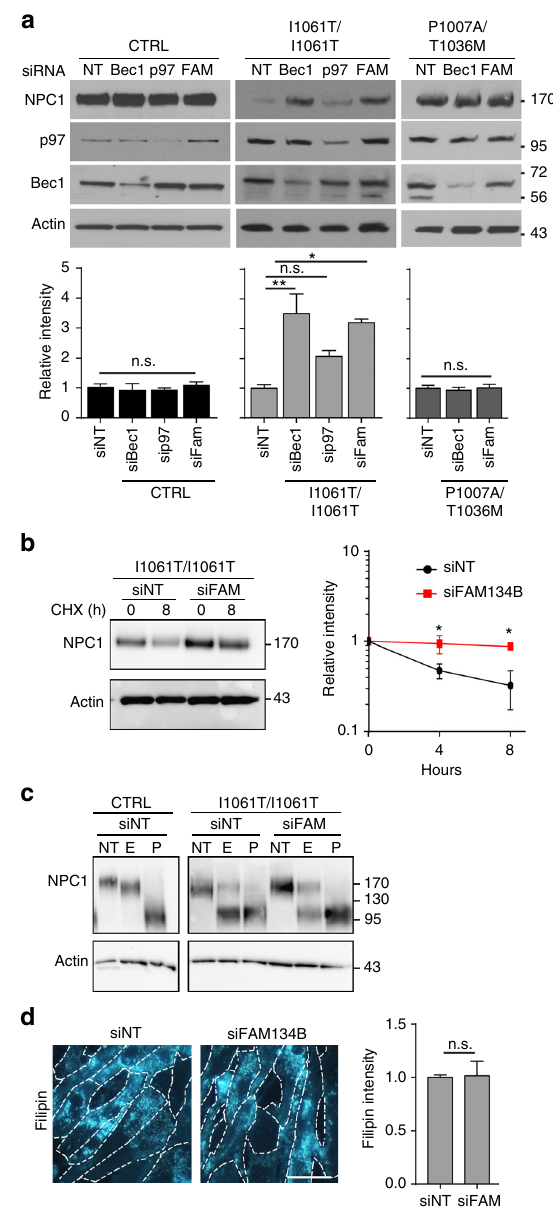
Fig. 5 I1061T is degraded by ER-phagy. a CTRL, I1061T, or P1007A/T1036M NPC1 fi broblasts were treated with the following siRNAs: non-targeting (NT), beclin-1 (Bec1), p97, and FAM134B (FAM) at t = 0 and t = 24h. Lysates were collected at t = 48h and NPC1 levels analyzed and quanti fi ed below. b I1061T NPC1 fi broblasts were treated for 2 sequential days with non-targeting siRNA (siNT) or siRNA FAM134B (siFAM134B), then treated with cycloheximide and serum starved. NPC1 protein levels were analyzed by western blot, quanti fi ed at right. c Lysates from a were digested with endoglycosidase H (E), PNGaseF (P), or not treated (NT) and then analyzed by western blot. d I1061T NPC1 fi broblasts were treated with siRNAs as in a . At t = 48h, cells were stained with fi lipin. Intensity quanti fi ed at right. Scale bar = 50 μ m. Data are mean±s.e.m. from a 3 – 6; b , c 3 independent experiments. n.s.,